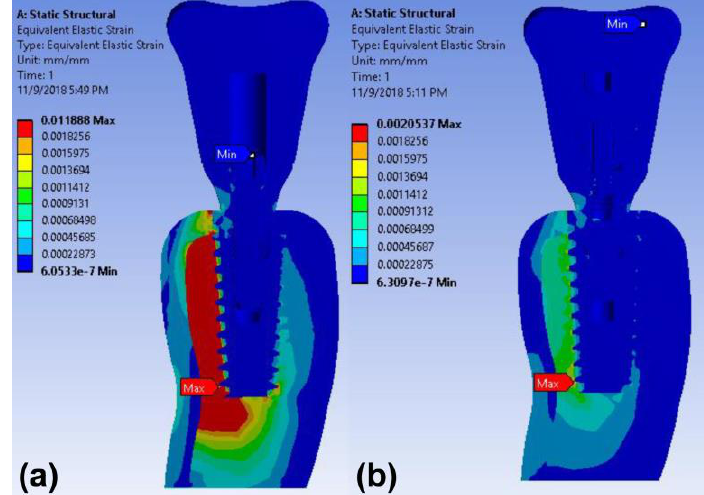
Figure 9. Color-coded strain distributions in the peri-implant bone under oblique load in the finite element model: ( a ) cement-retained zirconia crown model and ( b ) cementless screw-retained zirconia crown model.